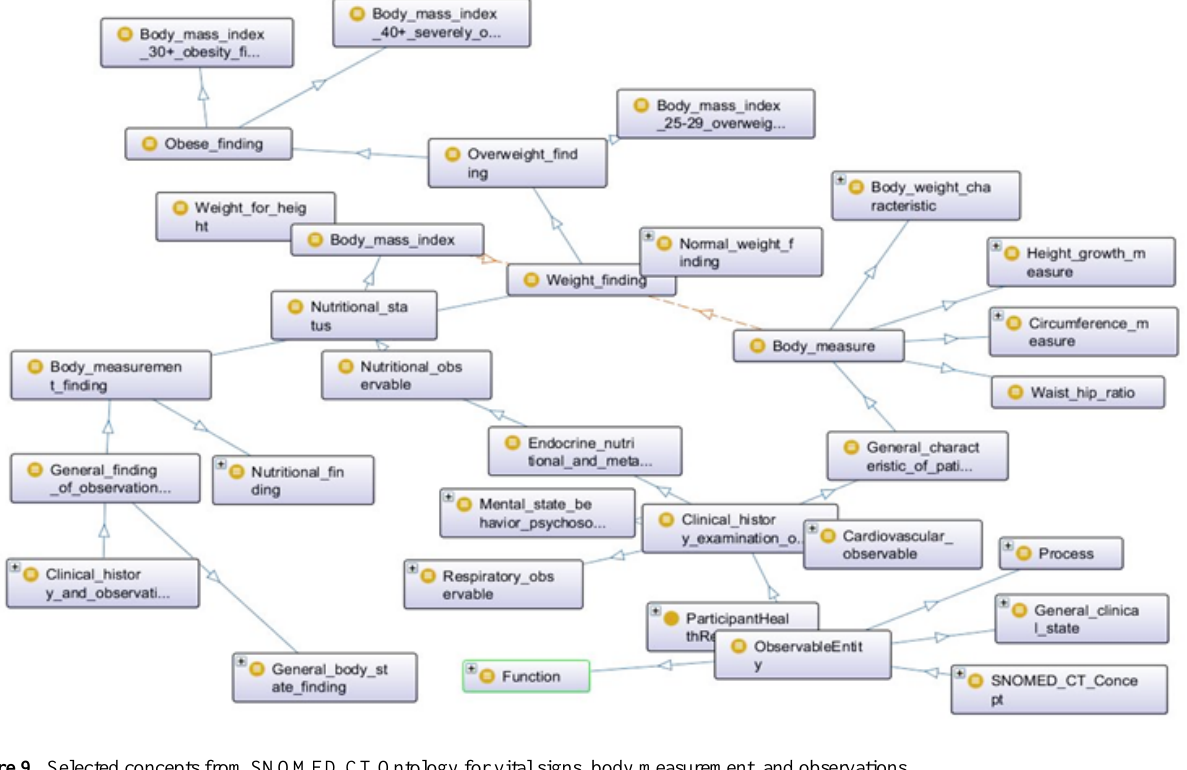
Figure 8. SNOMED CT ontology visualization with OntoGraf based on selected concepts.